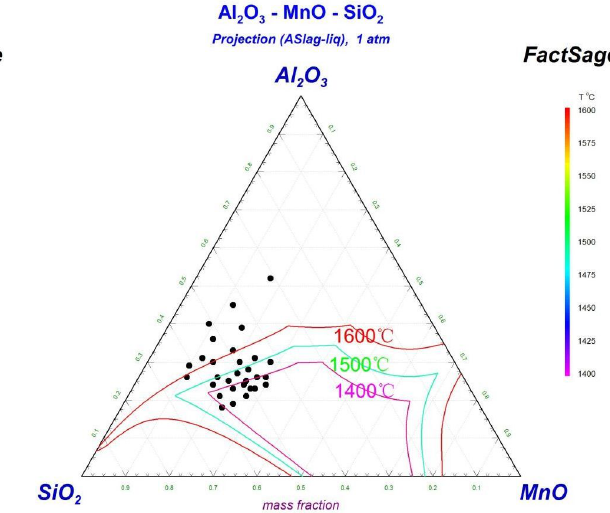
Figure 1: Composition distribution of inclusions in Al 2 O 3 -SiO 2 -MnO phase diagrams for S1